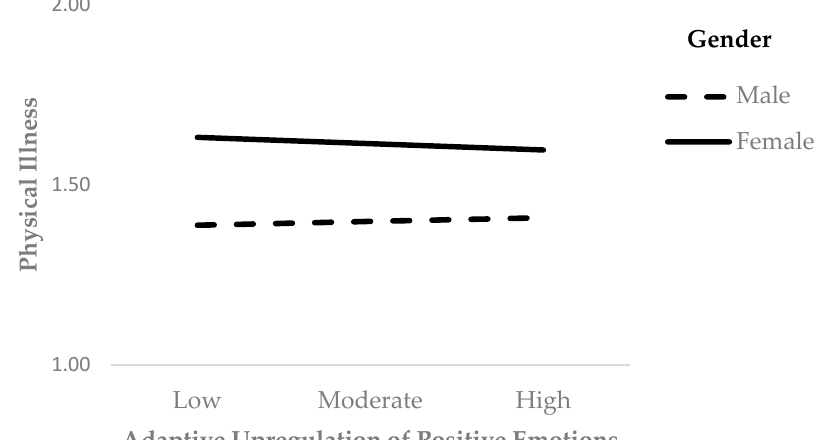
Figure 3. Adaptive upregulation of positive emotions predicting physical illness as a function of gender.